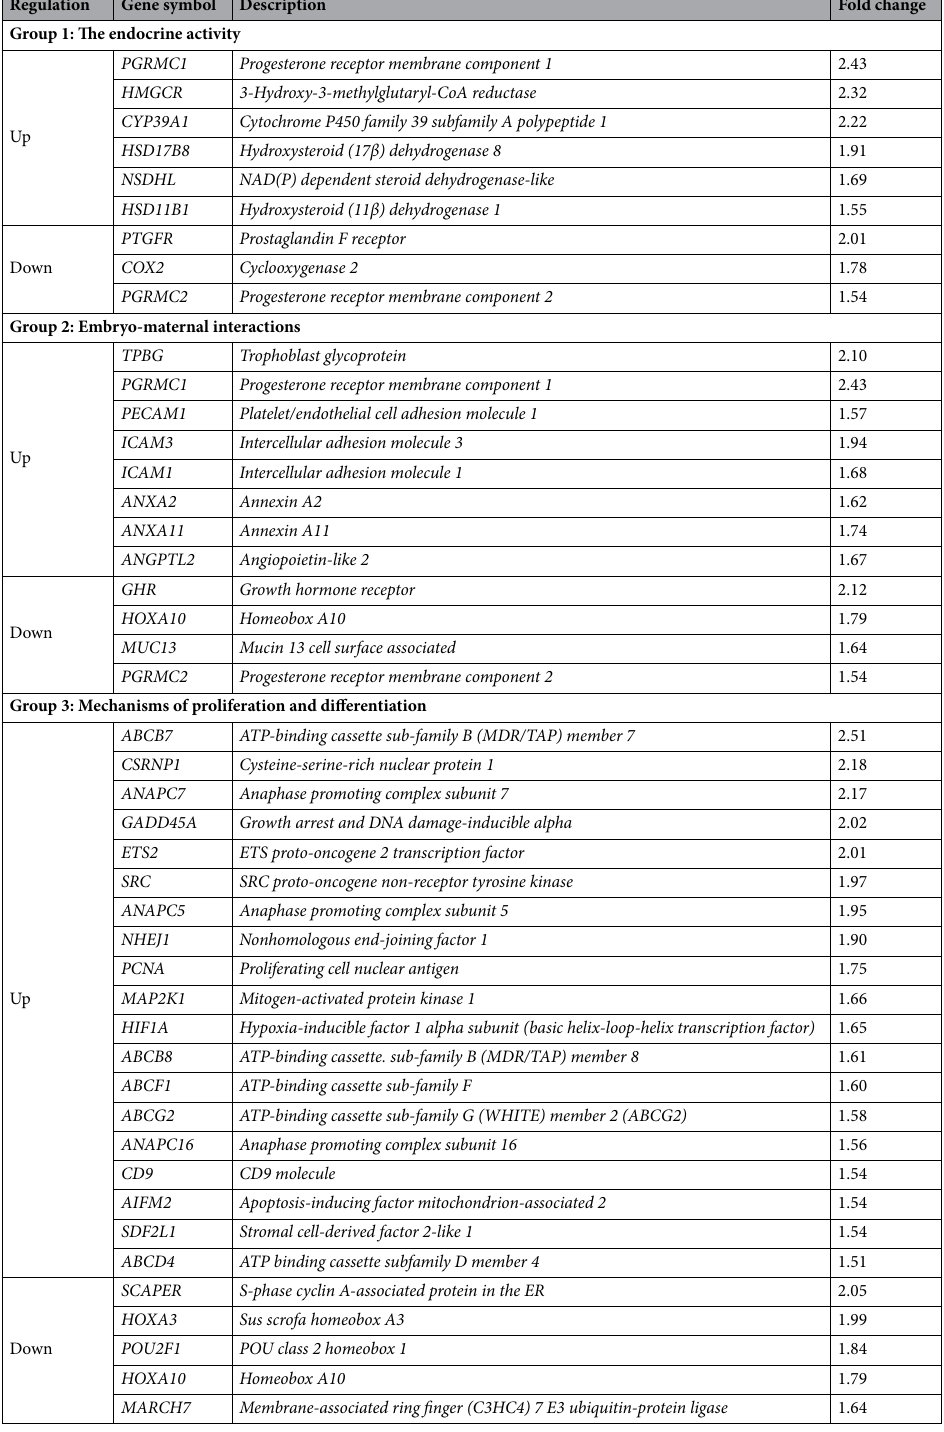
Table 2. The selected differentially expressed genes (DEGs) in response to peri-conceptional undernutrition in the myometrium of pigs during the peri-implantation period, classified based on the function of encoded